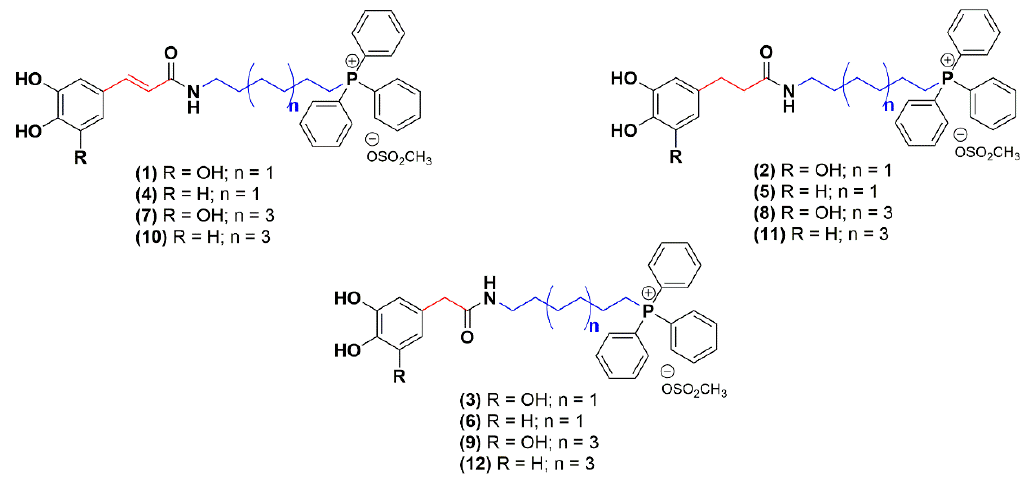
Table 1. Cholinesterases inhibitory activity (IC 50 ) data of the mitochondriotropic antioxidants and donepezil.